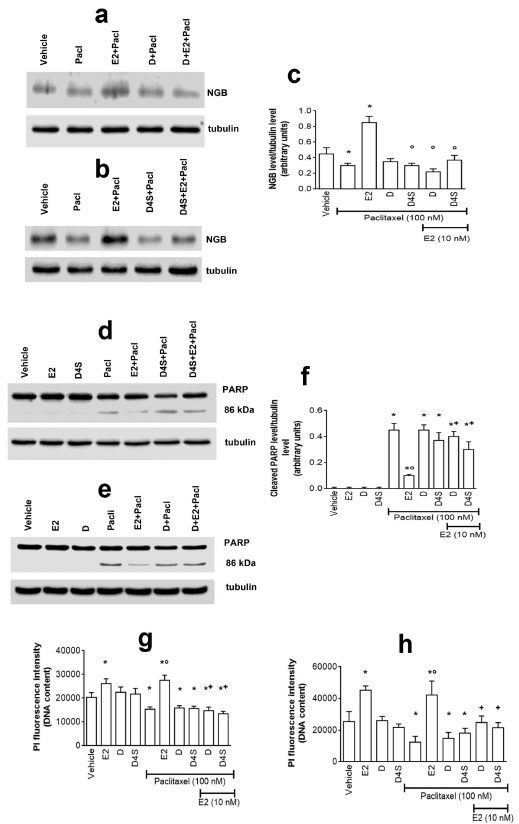
Figure 5. Physiological outcomes of D- and D4S-induced E2 / ER α / NGB pathway avoidance. Western blot (left) and densitometric analyses (right) of NGB levels ( a – c ) and PARP-1 cleavage ( d – f ) in MCF-7 cells. Cells were treated with D ( a , e ) or D4S ( b , d ) (1 µ M) in presence or absence of Pacl (100 nM) for 24 h, with either vehicle or E2; some Pacl treated cells were co-stimulated with either E2 or D or E2 together with D ( a , e ) or E2 or D4S or E2 together with D4S ( b , d ). ( c , f ) panels are densitometries that summarize the D- and D4S-induced modulation of NGB and PARP-1 cleavage respectively. The amount of protein was normalized by comparison with tubulin levels. Data are the mean ± SD of three di ff erent experiments. p < 0.001 was determined with Student t test with respect to the vehicle (*), Pacl-treated ( ◦ ) samples or D- and D4S-treated samples, co-stimulated with Pacl but not with E2 ( + ). E ff ects of cellular DNA content obtained from PI assay on MCF-7 ( g ) or T47D ( h ) cells. The cells were treated for 24 h with either vehicle (DMSO) or E2 (10 nM) or Pacl (100 nM; 24 h); some samples were treated with D or D4S (1 µ M) in presence or absence of Pacl and in presence of absence of E2. Data are mean ± SD of five di ff erent experiments. (*) p < 0.001 was calculated with Student t test versus vehicle or Pacl-treated ( ◦ ) samples or D- and D4S-treated samples, co-stimulated with Pacl but not with E2 ( + ). E2: estradiol; NGB: neuroglobin; DMSO: dimethyl sulfoxide; D: daidzein; Eq: equol;